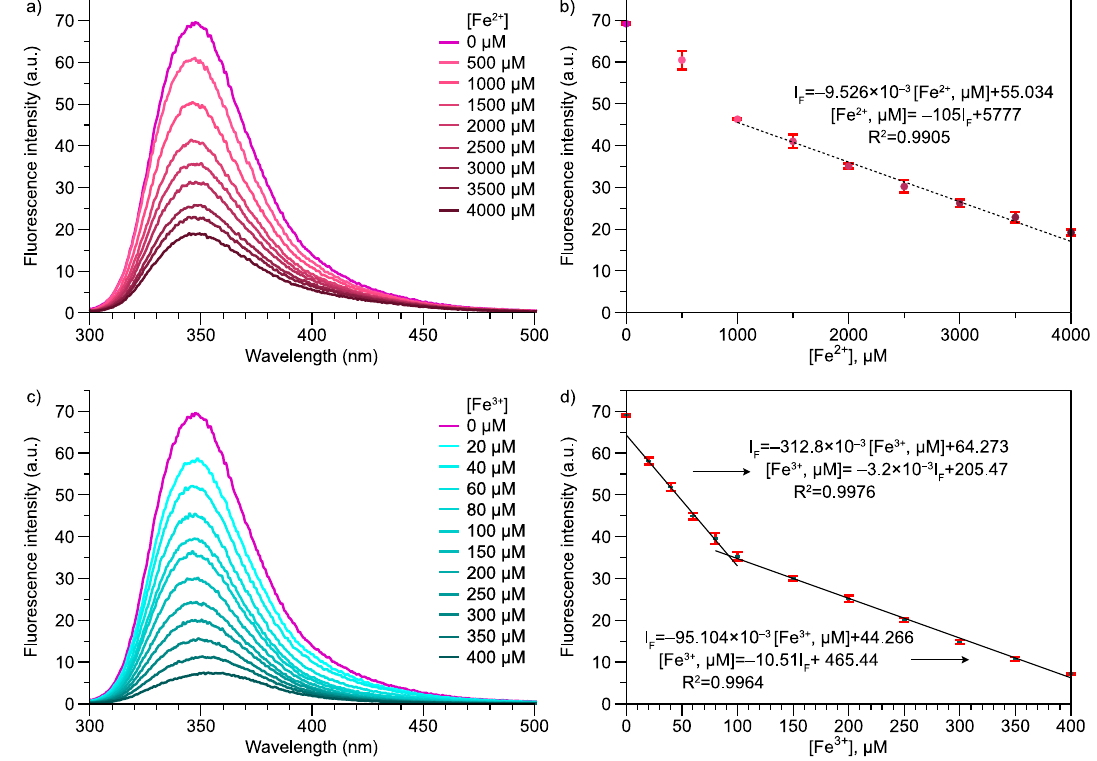
Figure 5. Poly(Ani-AMPS) fluorescence emission spectra regarding the concentration of ( a ) Fe 2+ and ( c ) Fe 3+ . The plot of the emission intensity at 348 nm vs. the concentration of ( b ) Fe 2+ and ( d ) Fe 3+ .